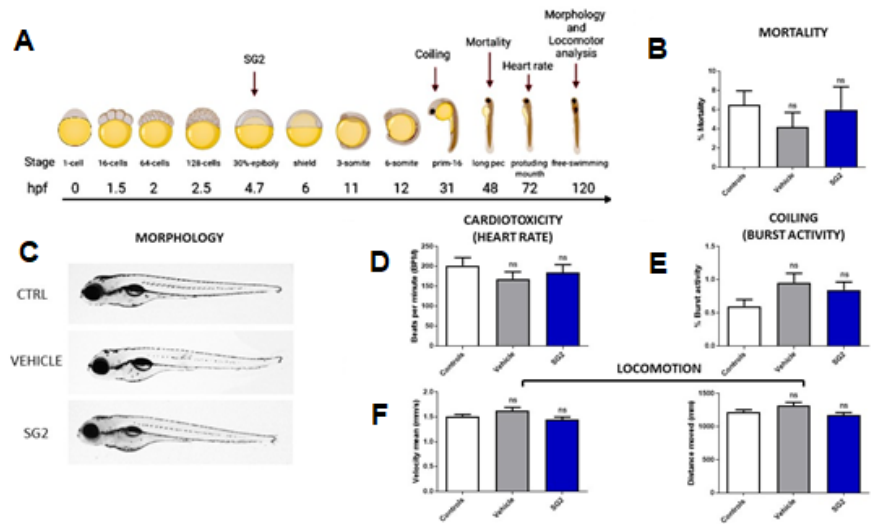
Figure 5. SG2 does not show toxicological effects in zebrafish. ( A ) SG2 at 5 µM was administered to zebrafish embryos at 4 h post fertilization (hpf); the experimental workflow was created with BioRender.com( accessed on 5 May, 2021). All the experiments reported show non-significant values compared to controls, proving a safe impact of SG2 in zebrafish. ( B , C ) Mortality rate was calculated until 48 hpf ( B ) (controls N = 545, vehicle N = 281, SG2 N = 224) and no morphological anomaly was observed at 5 days post fertilization (dpf) ( C ). ( D ) Cardiotoxicity was evaluated measuring heart rate at 3 dpf. ( E , F ) Neurological development was evaluated at 30 hpf with burst activity analysis ( E ) and at 5 dpf with locomotor measurements considering velocity and distance covered ( F ) (controls N = 366, vehicle N = 212, SG2 N = 246). All experiments were performed at least in triplicate. Error bars represent the SEM. For statistical tests non-parametric one-tailed Mann-Whitney rank sum test was used.